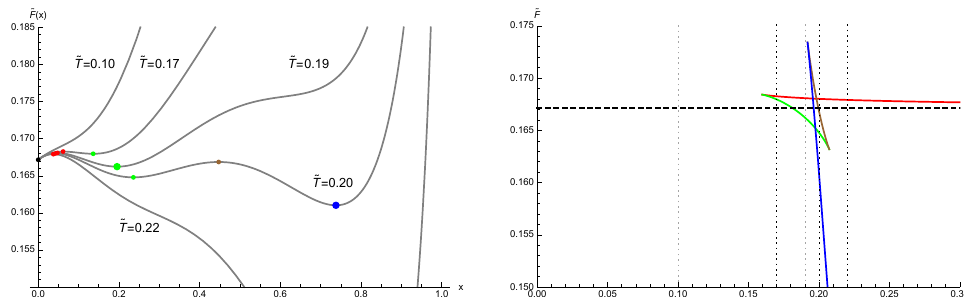
Figure 4. Region III: ~ a = 0 : 05 and ~ Q = 0 : 415. The BI BHs in this region are Schwarzschild- like type, which implies that x can go to 0. Left Panel : the locally stationary points of ~ F ( x ) are represented with colored dots, and ~ F (0) is marked with the black dot. Larger colored dots represent global minimums of ~ F ( x ). If there is no larger colored dot for some ~ T , ~ F ( x ) has the global minima at x = 0. Right Panel : the colored branches are the values of ~ F ( x ) evaluated at the locally stationary points as functions of ~ T . Speci(cid:12)cally, the blue/green branches are Large/Small BH, and the brown/red branches are Intermediate BH. The horizontal black dashed line is ~ F (0). As ~ T increases from zero, a (cid:12)rst-order phase transition from the edge state to Small BH occurs at some ~ T . Further increasing ~ T , there would be another (cid:12)rst-order phase transition from Small BH to Large